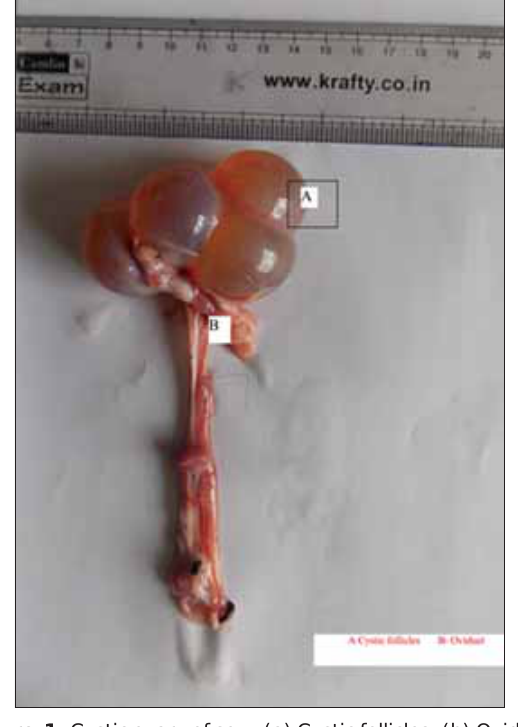
Figure-1: Cystic ovary of sow, (a) Cystic follicles, (b) Oviduct. Table-1: Mean values (±SE) of various biochemical metabolites of follicular fluid of sow.